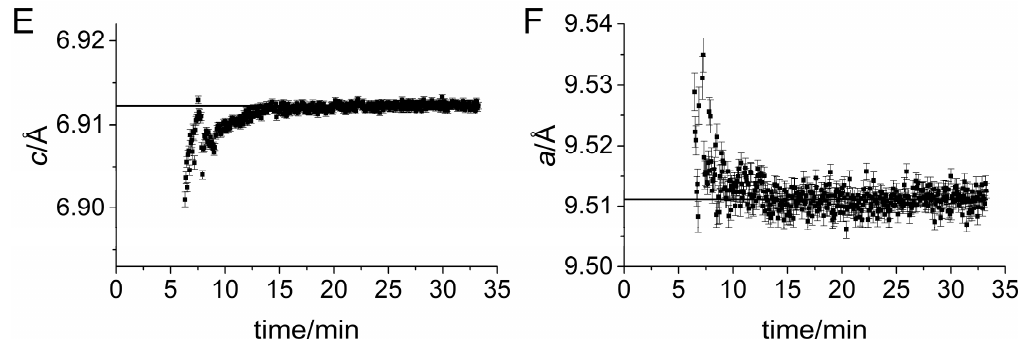
Fig.1 Figure 1. Results of Rietveld refinements of in situ diffraction data on the pyrophosphate free system. Horizontal lines represent the average of the last 100 s of the experiment. ( A ) Scale factor. Data points in gray are from refinements where the confidence in the results are lower due to convergence and/or local minima issues (see text); ( B ) refined calcium occupancy; ( C , D ) apparent crystallite sizes parallel and perpendicular to the c -axis, respectively; and ( E , F ) the refined lattice constants of the hexagonal apatite unit cell shown on the same relative scale. In panels ( B – F ), only results where the parameters were well-defined are shown; at earlier times the parameters were not determinable due to the extremely low or zero diffraction signal from